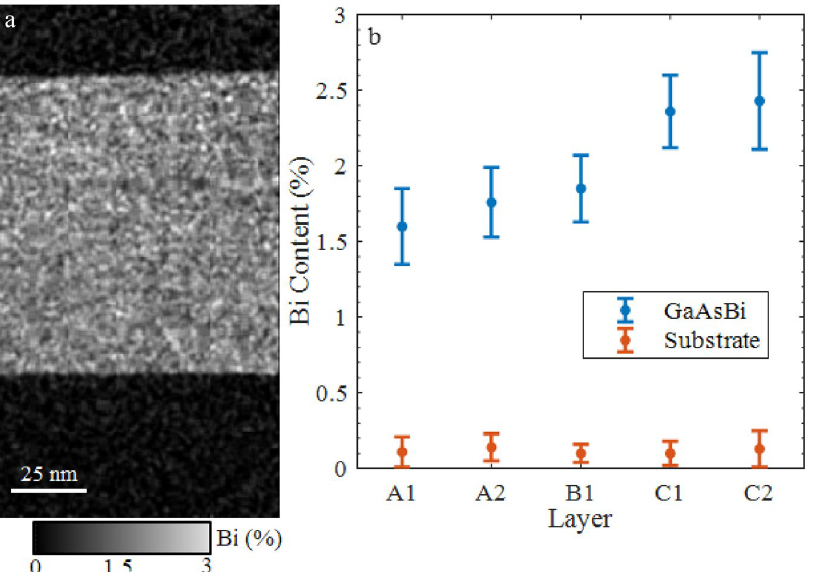
Figure 2. ( a ) EDX image of layer A1 and ( b ) Bi content in all control layers with standard deviation (error bars). Growth details for these layers are in the supplementary